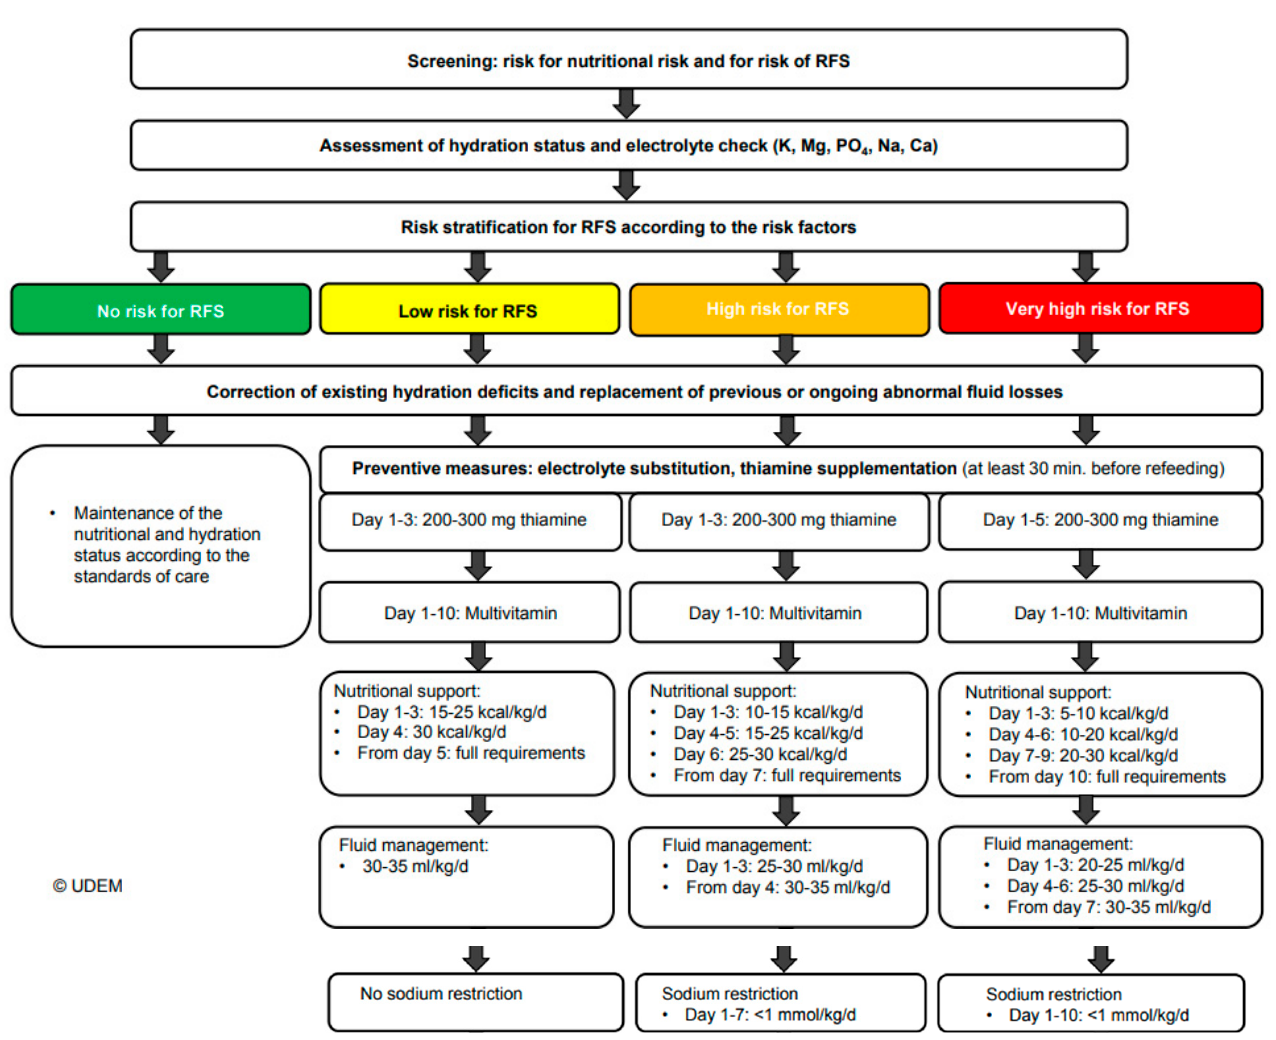
Figure 4. Screening and prevention algorithm. Adapted with permission from Ref. [24]. 2017, Divi- sion of Diabetes, Endocrinology, Nutritional Medicine and Metabolism, University Hospital, Bern.